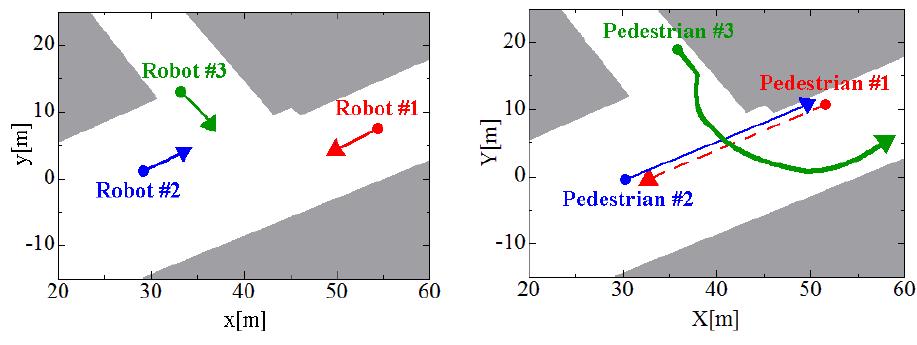
Figure 10. Movement path of robots and pedestrians. ( a ) Robot path. ( b ) Pedestrian